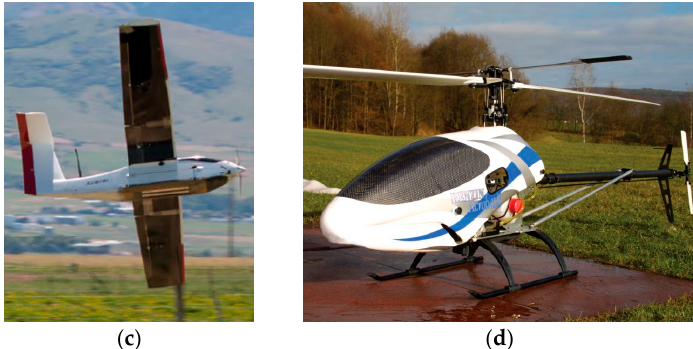
Figure 2. Examples of unmanned aircraft systems (UAS) used to study water status in horticulture crops: ( a ) hexacopter equipped with RGB, multispectral and thermal camera at The University of Adelaide, Adelaide, Australia ( b ) quadcopter equipped with a thermal and multispectral camera [100], ( c ) fixed-wing aircraft used for GRAPEX project to carry RGB, thermal and monochrome camera with narrowband filters [101], and ( d ) helicopter used for various studies of crop water status [18,92,102].